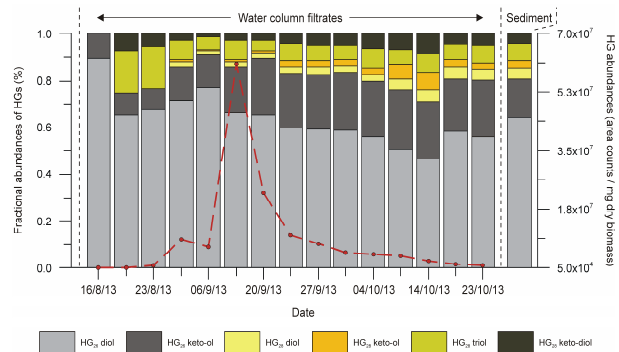
Figure 3. Fractional abundances of HGs in surface waters of Lake Schreventeich. Dashed line indicates relative abundances of the sum of all heterocyst glycolipids normalized to the amount of phyto- plankton biomass over the investigated time interval. Note that het- erocyst glycolipids were not detected in water column filtrates taken before mid-August. Fractional abundances of HGs in the sediment of Lake Schreventeich represent average values obtained from the analysis of two core top